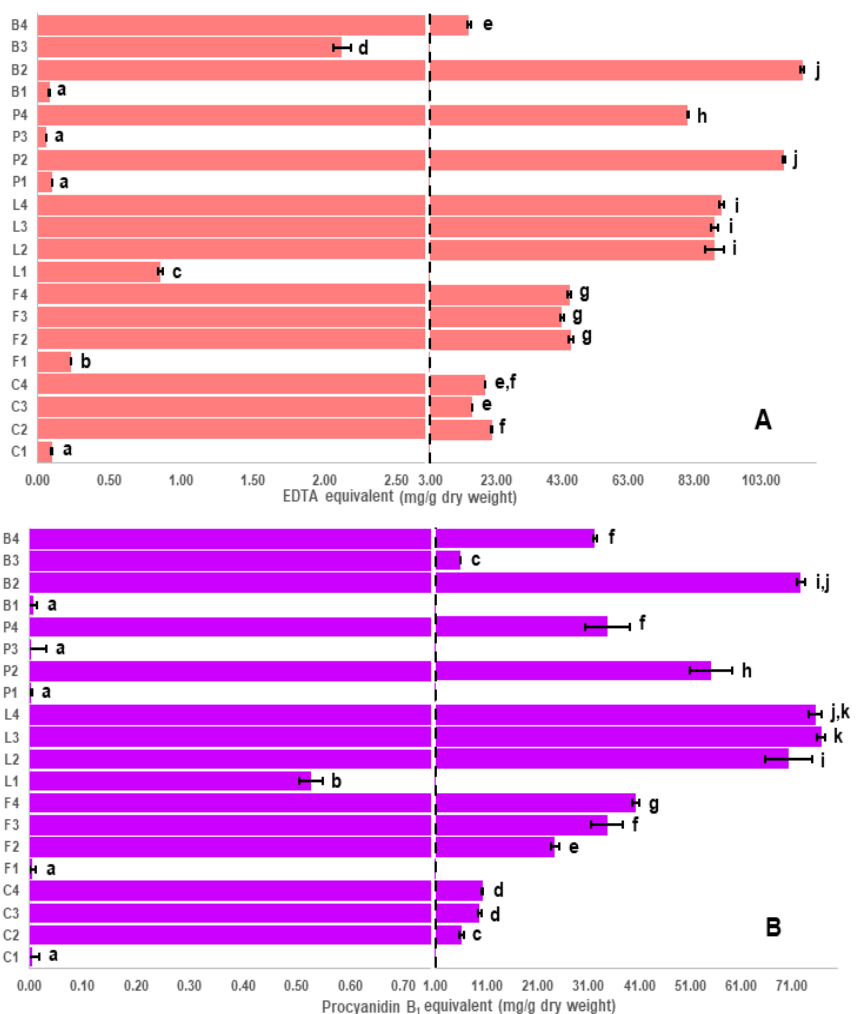
Figure 3. Iron chelation ability ( A ) and proanthocyanidin content ( B ) of different genotypes of pulse seed coats using Ferrozine and DMAC assays, respectively. Letters on y-axis refer to different pulse crops; C: chickpea, F: faba bean, L: lentil, P: pea and B: common bean, whereas numbers refer to different seed coat colors. For example, L2 refers to black seed coats of Indianhead lentil (see Table 3 for code). Bars with different letters for each assay are significantly different ( p < 0.05). Table 1. Pearson correlations among the measured assays and polyphenol subclasses previously measured in pulse seed coat extracts. Excluding the antioxidant capacity measured by the F-C assay, green-highlighted cells refer to the highest correlations between polyphenol classes and antioxidant capacity, orange-highlighted cells refer to the correlations of antioxidant capacity measured by different assays, blue-highlighted cells refer to the correlations between proanthocya- nidin content and antioxidant capacity, and pink-highlighted cells refer to the correlation between proanthocyanidin con- tent and iron chelation ability.